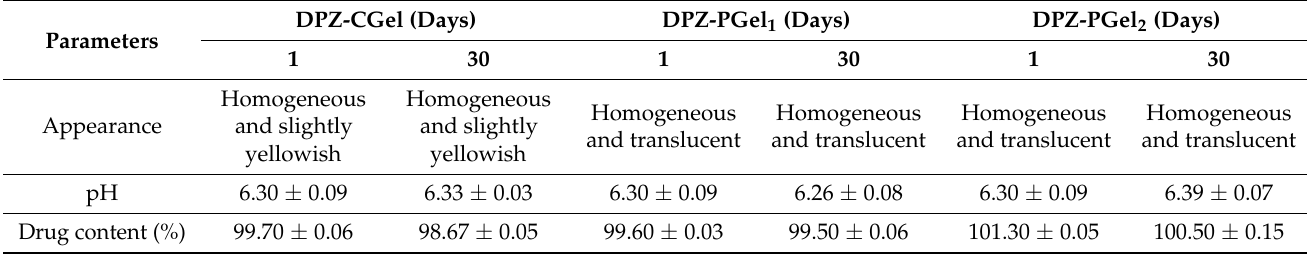
Table 4. Stability studies of chitosan and Pluronic F-127 formulations at 40 ± 2 ◦ C/75 ± 5%